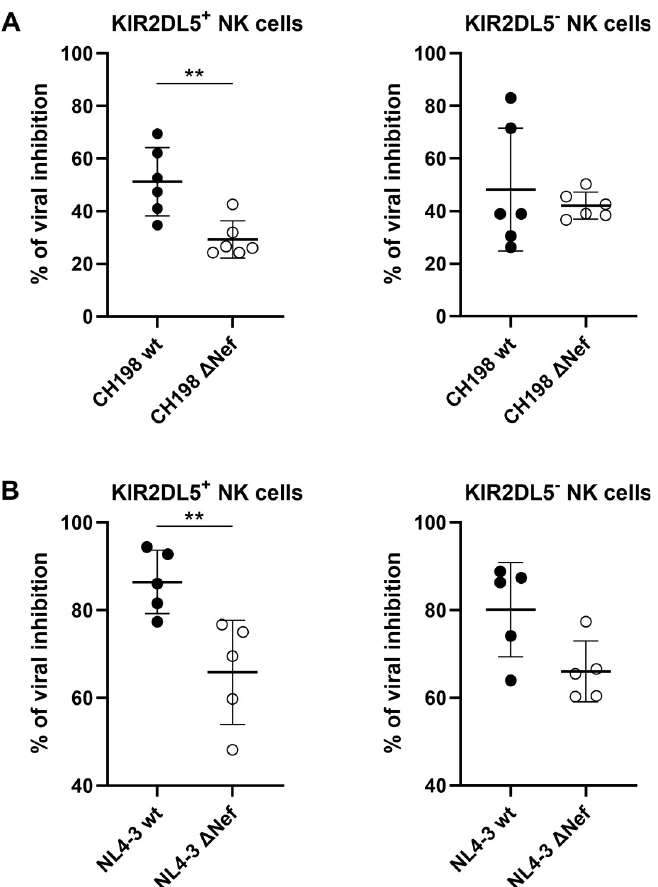
Fig 5. Inhibition of HIV-1 replication by KIR2DL5 + and KIR2DL5 - NK cells. Anti-viral activity of KIR2DL5 + and KIR2DL5 - NK cells was evaluated by co-culture of KIR2DL5 + and KIR2DL5 - NK cell clones with HIV-1 CH198 (A) and NL4-3 (B) wt and Δ Nef virus infected autologous CD4 + T cells. Graphs show the percentage of viral inhibition based on the percentage of p24 + CD4 + T cells in co-culture with NK cells compared to the CD4 + T cell only control where no NK cells were added. Viral inhibition was calculated as 100 � (1-(percentage of p24 + CD4 + T cells with NK cells / percentage of p24 + CD4 + T cells without NK cells)). Mann-Whitney test was used to calculate statistical significance of differences in viral inhibition between wt and Δ Nef viruses (CH198: p = 0.009; NL4-3: p = 0.008). Data were obtained by using six (for CH198 viral inhibition) and five (for NL4-3 viral inhibition) KIR2DL5 + and six/five KIR2DL5 - NK cell clones from two donors (CH198: n = 6; NL4-3: n = 5) and results are shown as mean values with SD.